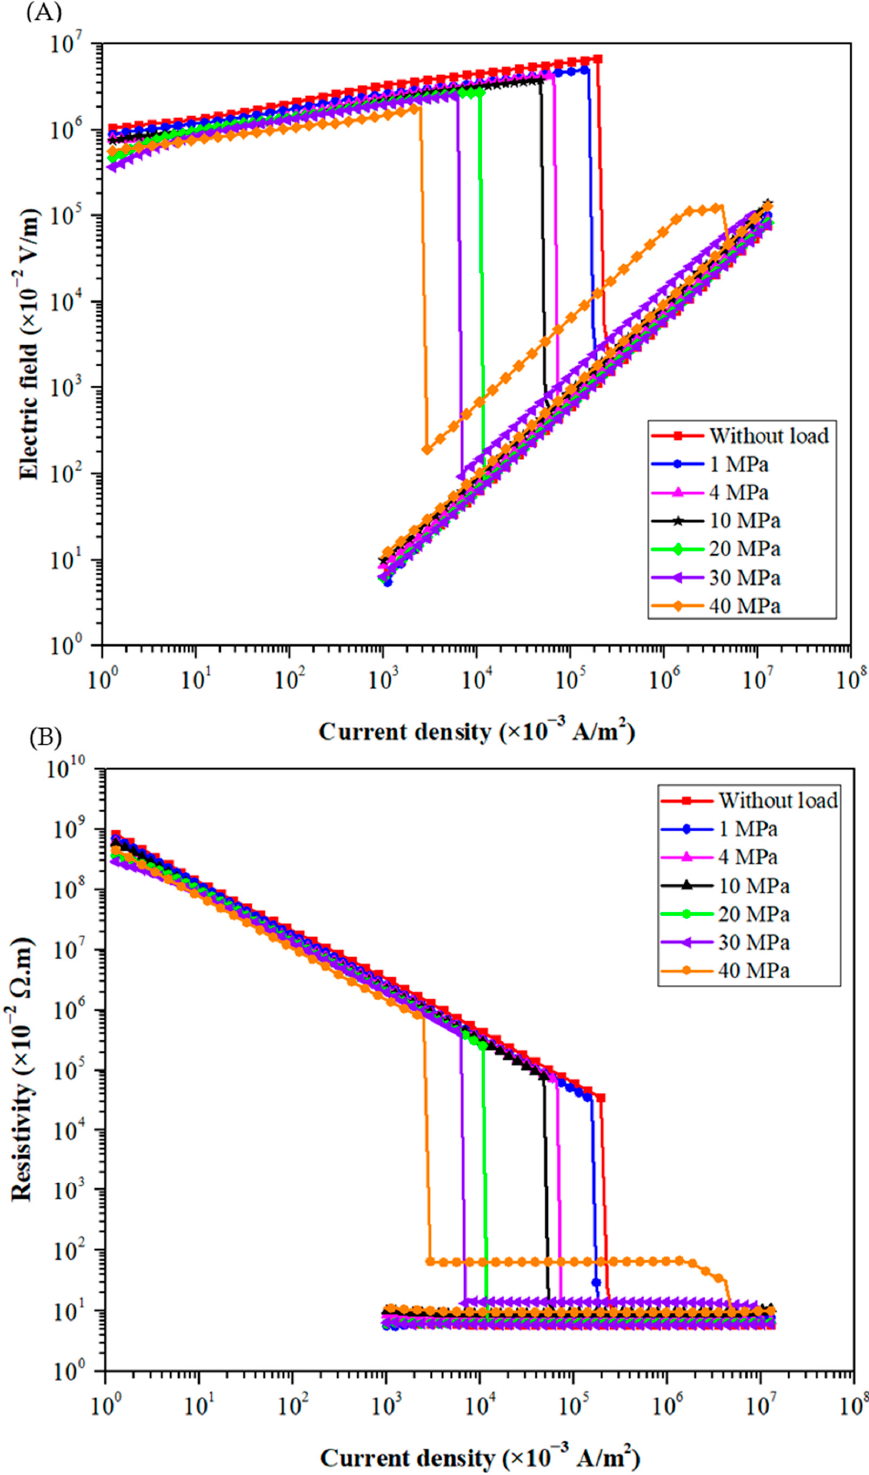
Figure 7. Evolutions of ( A ) electric field vs. current density and ( B ) resistivity vs. current density during current cycles up to 1 A for the raw powder submitted to a low uniaxial stress up to 40 MPa.